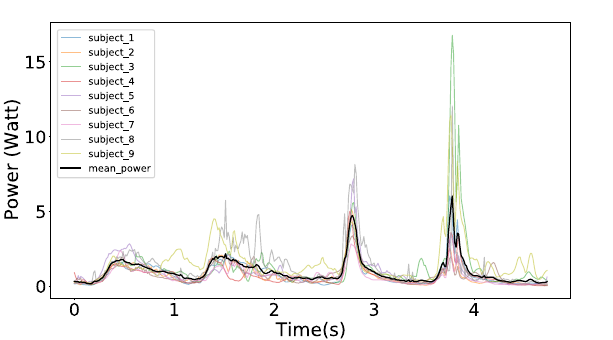
Figure 1. The nine 3-dimensional paths in the virtual environment that were used in the experiment. They are ordered by their complexity. For reference, colors denote common segments and points. For the subjects, the paths were all rendered in black, The scale is in meters.